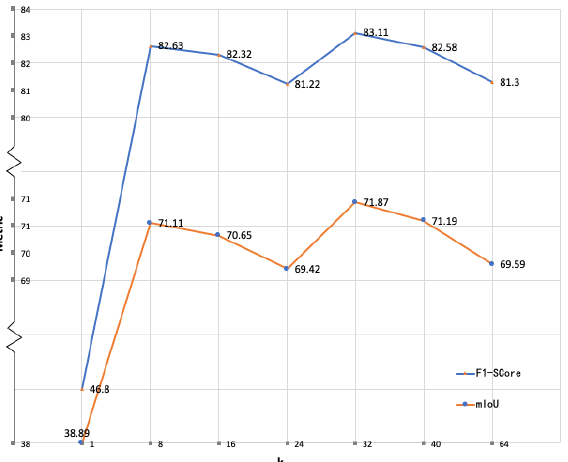
Figure 12. Comparison experiments of different values of the hyper-parameter k of the proposed C-FCN, measured by mean F1-score (%) and mean IoU (%) of all test